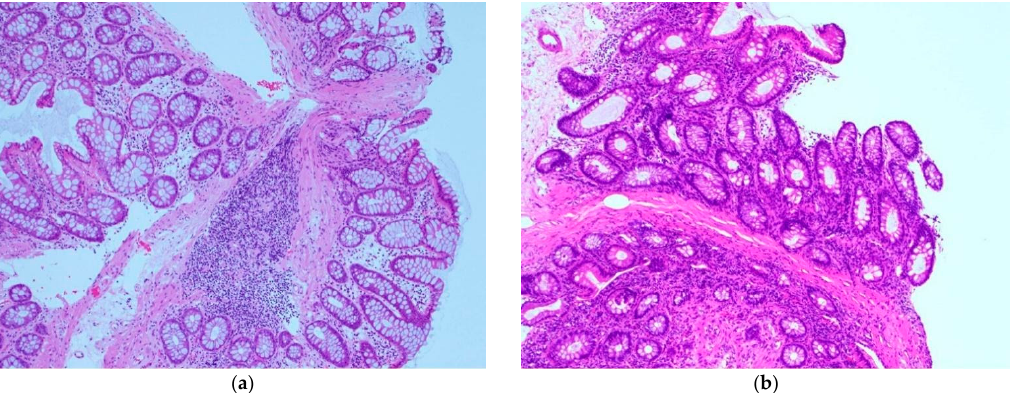
Figure 4. Colonic specimens. From ( a , b ), Infiltration of Inflammatory cells, lymphocytes and plasma cells, partly eosinophils was seen in mucous tissue. There is no obvious malignant findings.